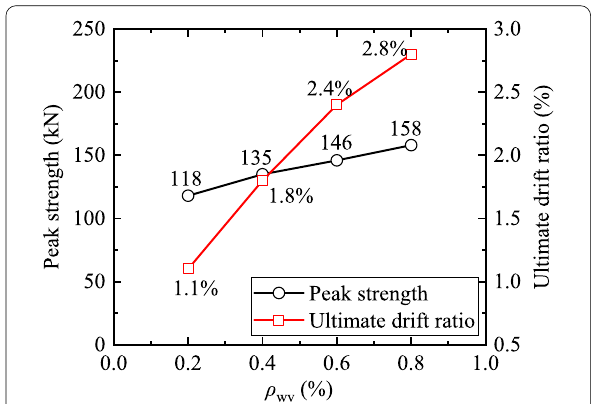
Fig. 15 Peak strength and ultimate drift ratio of specimens versus vertically web distributed reinforcement.